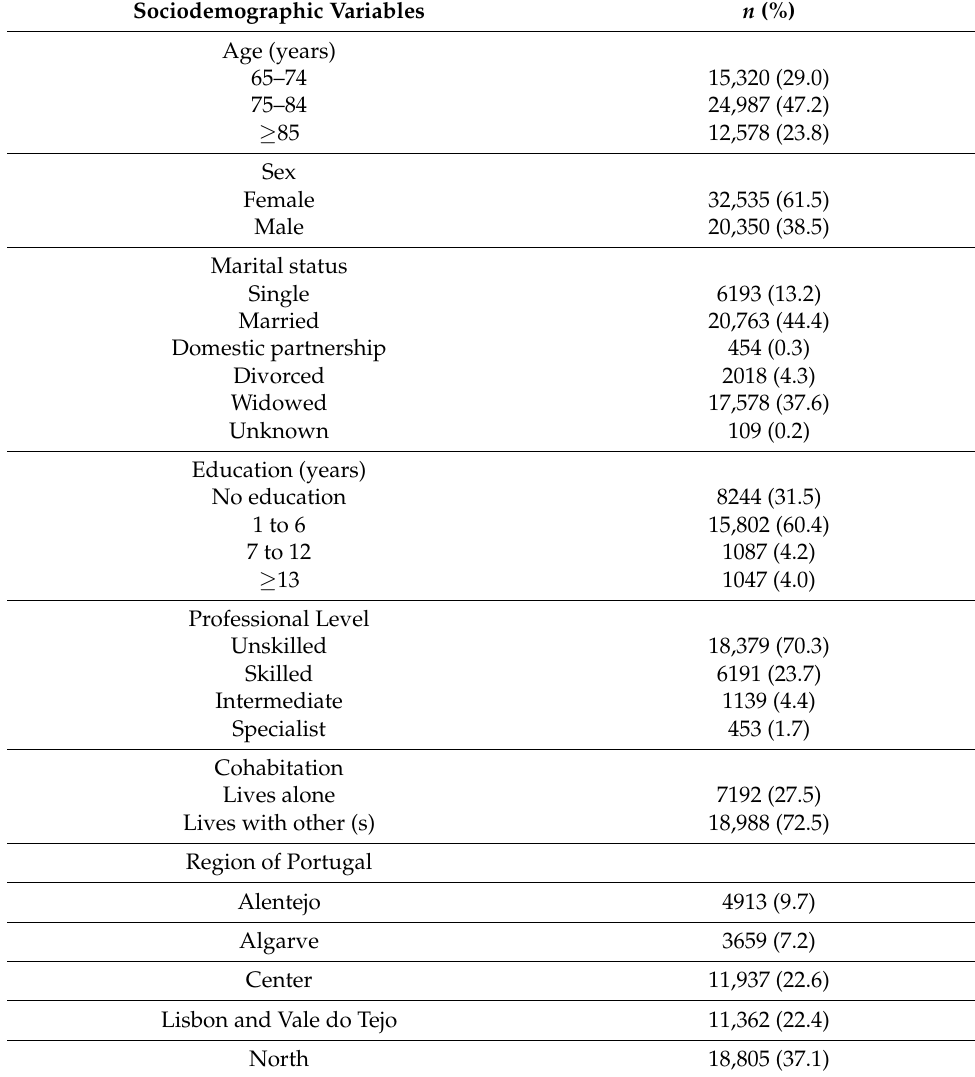
Table 1. Sociodemographic characterization of older adults hospitalized in convalescence units by sex